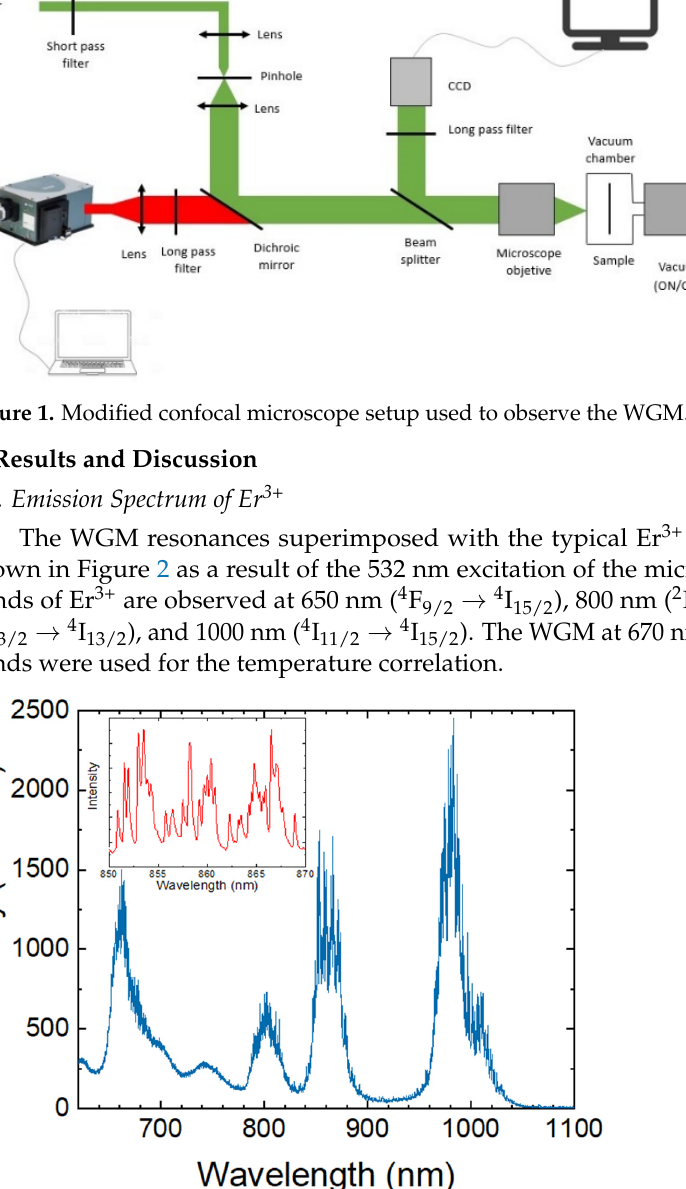
Figure 2. Emission spectrum of Er 3+ -doped BTS glass microsphere under a 532 nm excitation. Inset: Close up of the WGM resonant peaks in the 850 nm emission band.